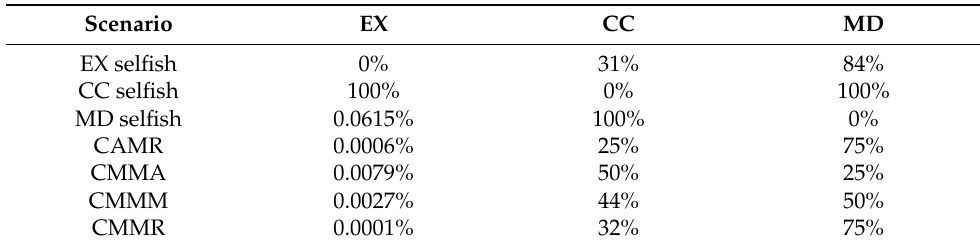
Table A2. Achieved levels regarding system expenditures, GHG emissions and metal depletion of each scenario in respect to the nadir